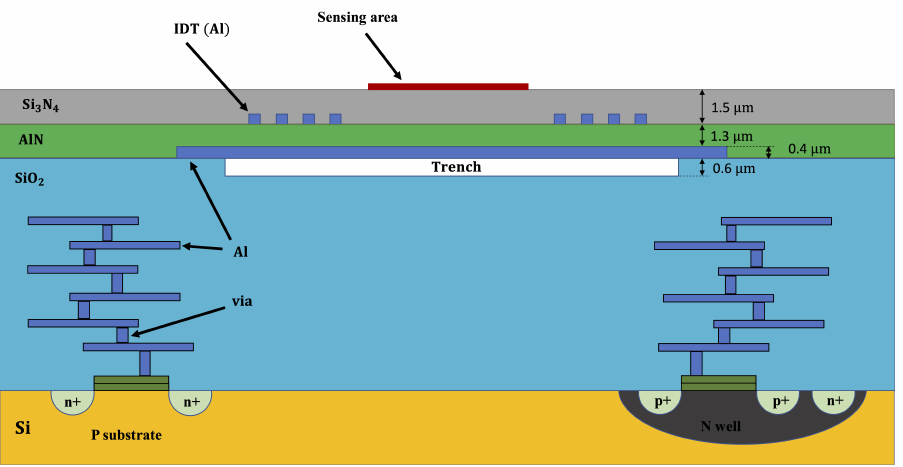
Figure 3. Cross-section of the Lamb wave microsensor realized with the CMOS Silterra technology. In this work, COMSOL Multiphysics 6.0, Stockholm, Sweden, was used to perform finite-element method (FEM) simulations. An sinusoidal electrical signal was applied to the input IDT and transformed into mechanical waves through the piezoelectric layer (as shown in Figure 4, 200 ns after voltage application). The resulting induced electrical signal at the output IDT was monitored and analyzed to design a sensitive mass sensor. ×10 (cid:2879)(cid:2869)(cid:2869)